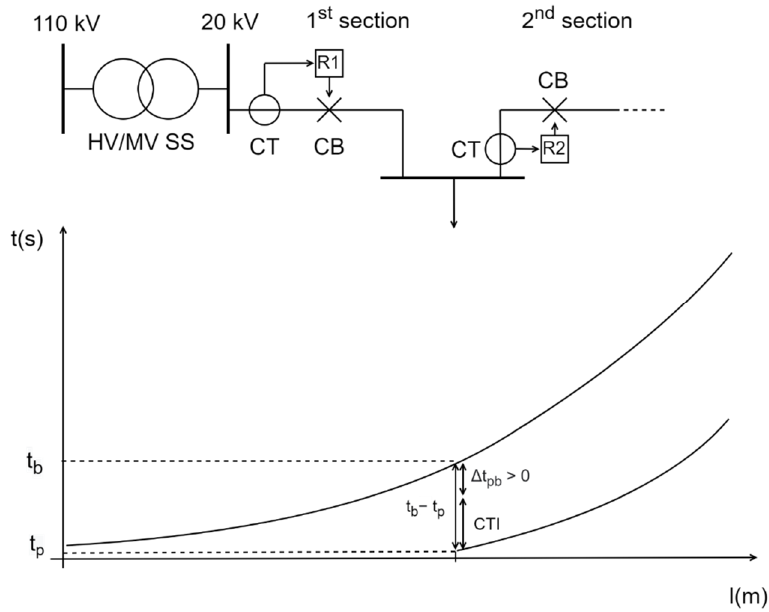
Figure 7. Proper coordination between a primary and backup relay.